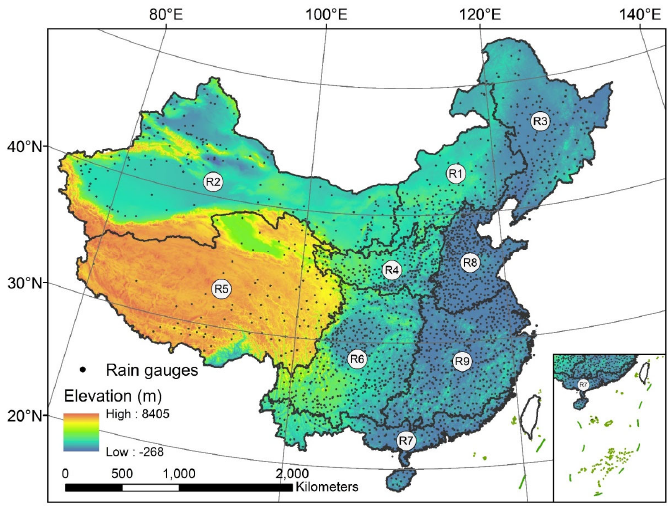
Figure 1. Digital elevation model and the location of the nine agricultural regions of mainland China, together with the distribution of 2413 rain gauges throughout mainland China.